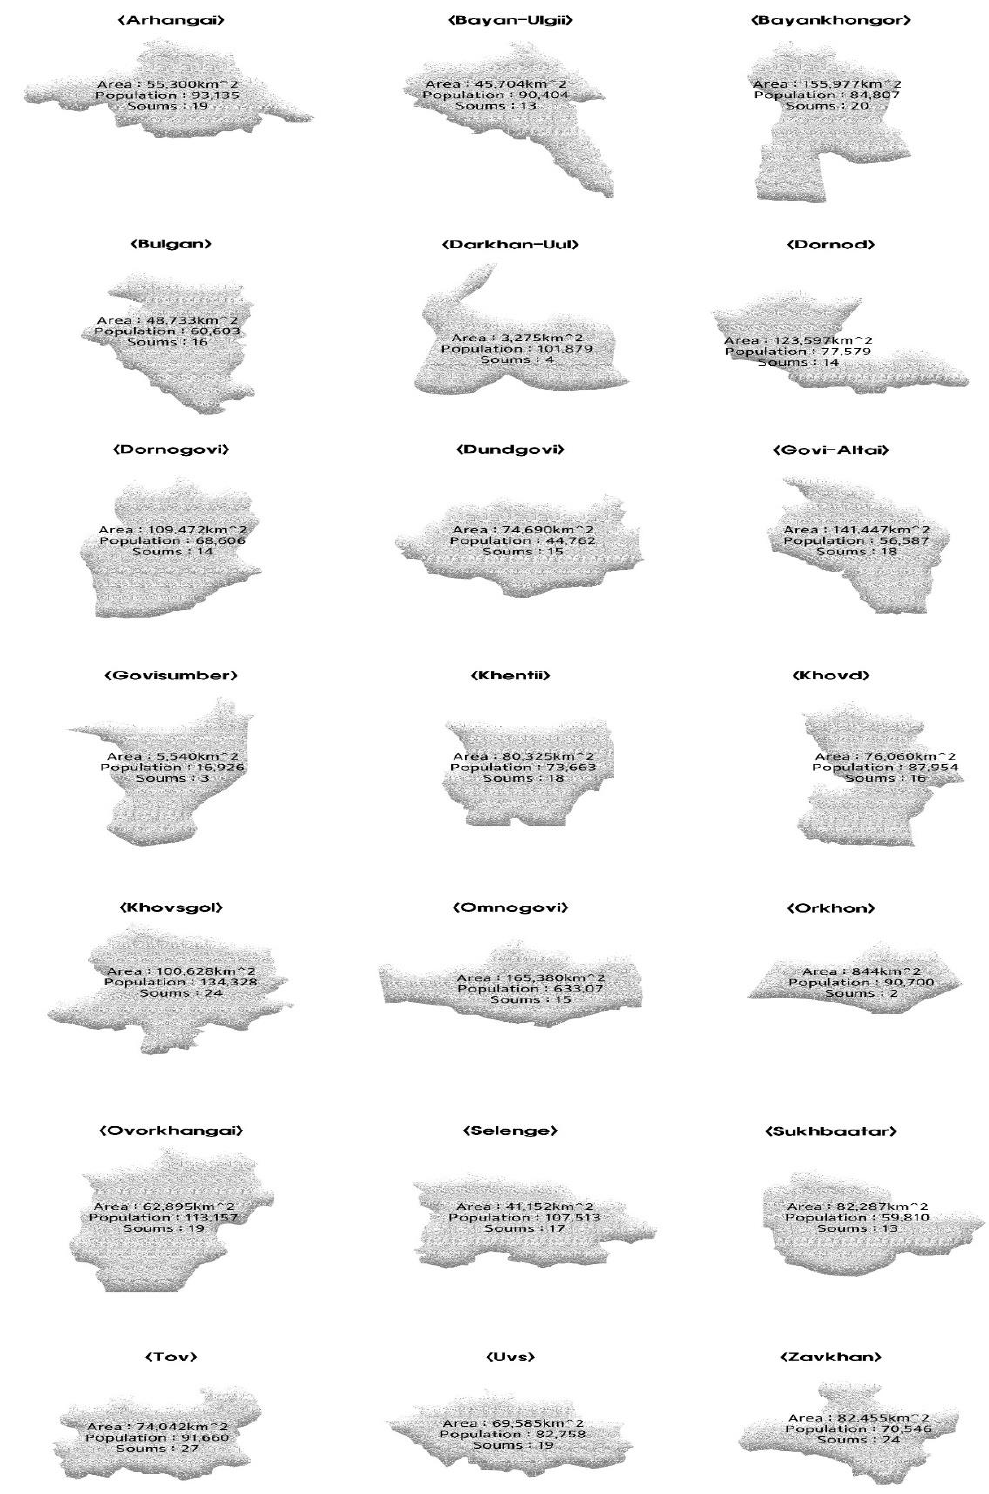
Figure 8. Information about each province in Mongolia.